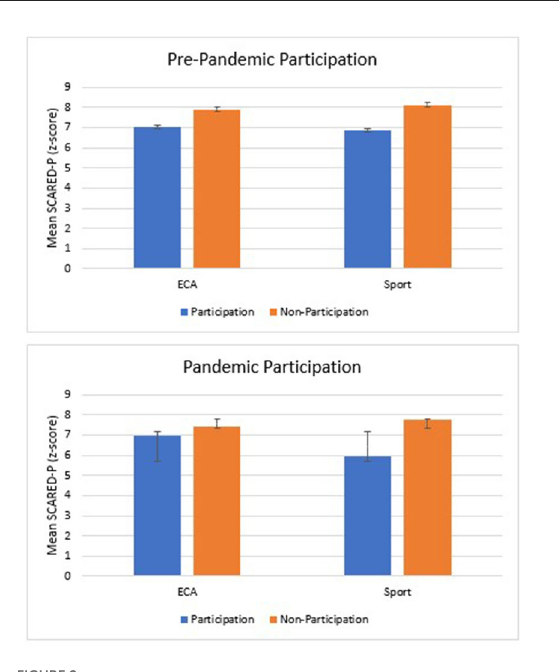
FIGURE2 Mean anxiety symptoms in school sports comparing pre-COVID and during-COVID participation. Anxiety symptoms were reported by parents though the SCARED (Screen for Child Anxiety Related Disorders); Error bars represent standard